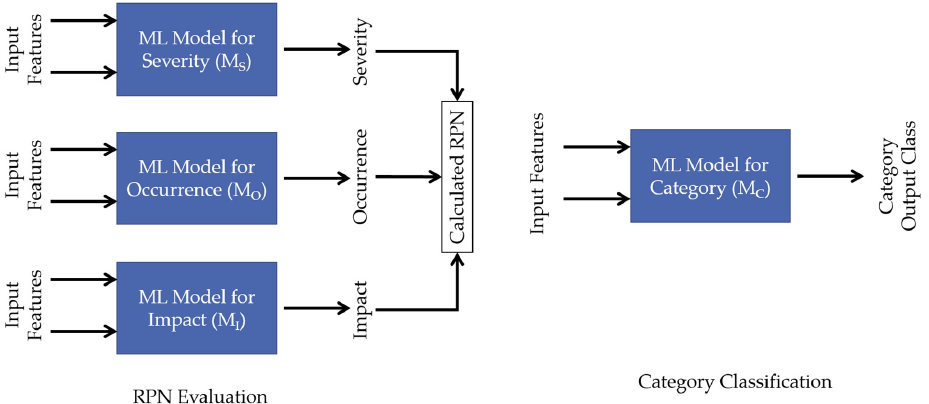
Figure 7. RPN evaluation and Category Classification models.